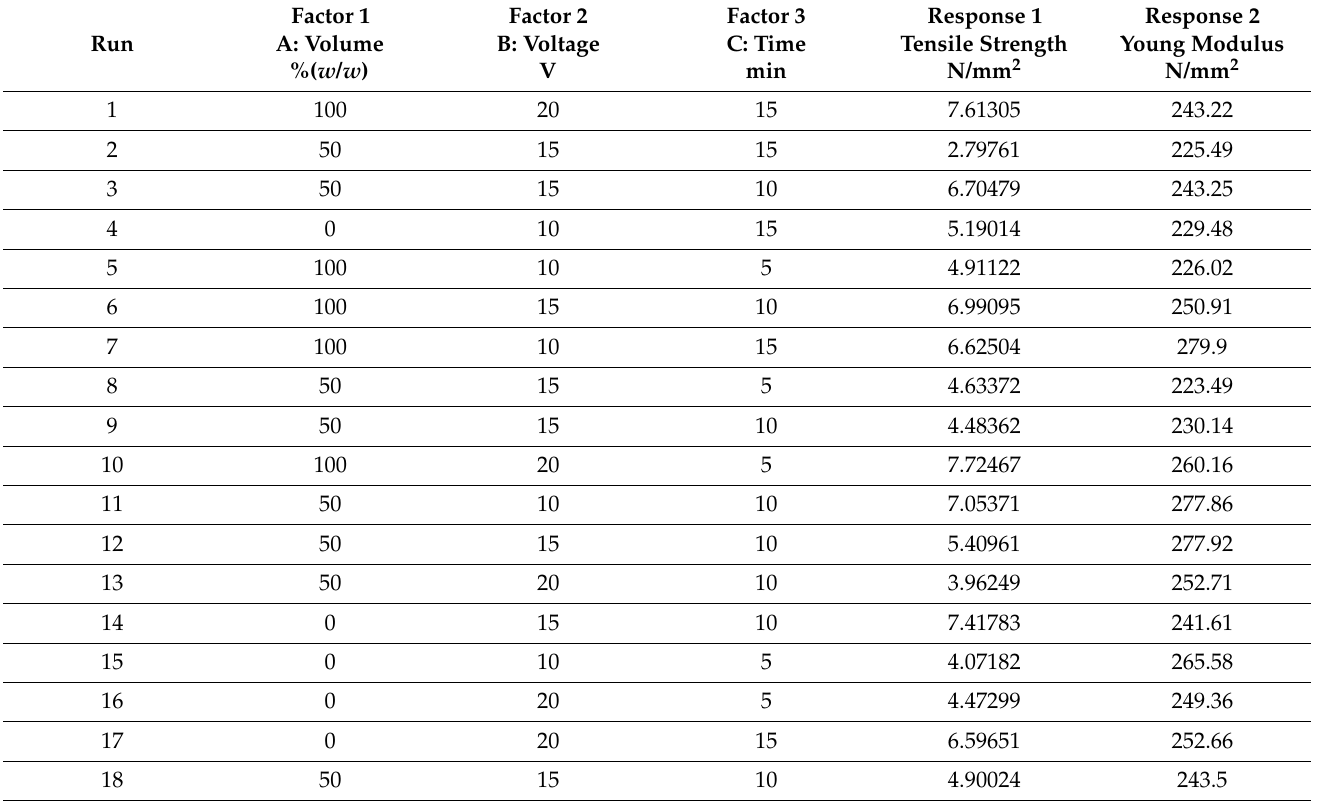
Table 7. Tensile strength and Young’s modulus of CNT–CF/epoxy composites with different factor values for 0% and 100%